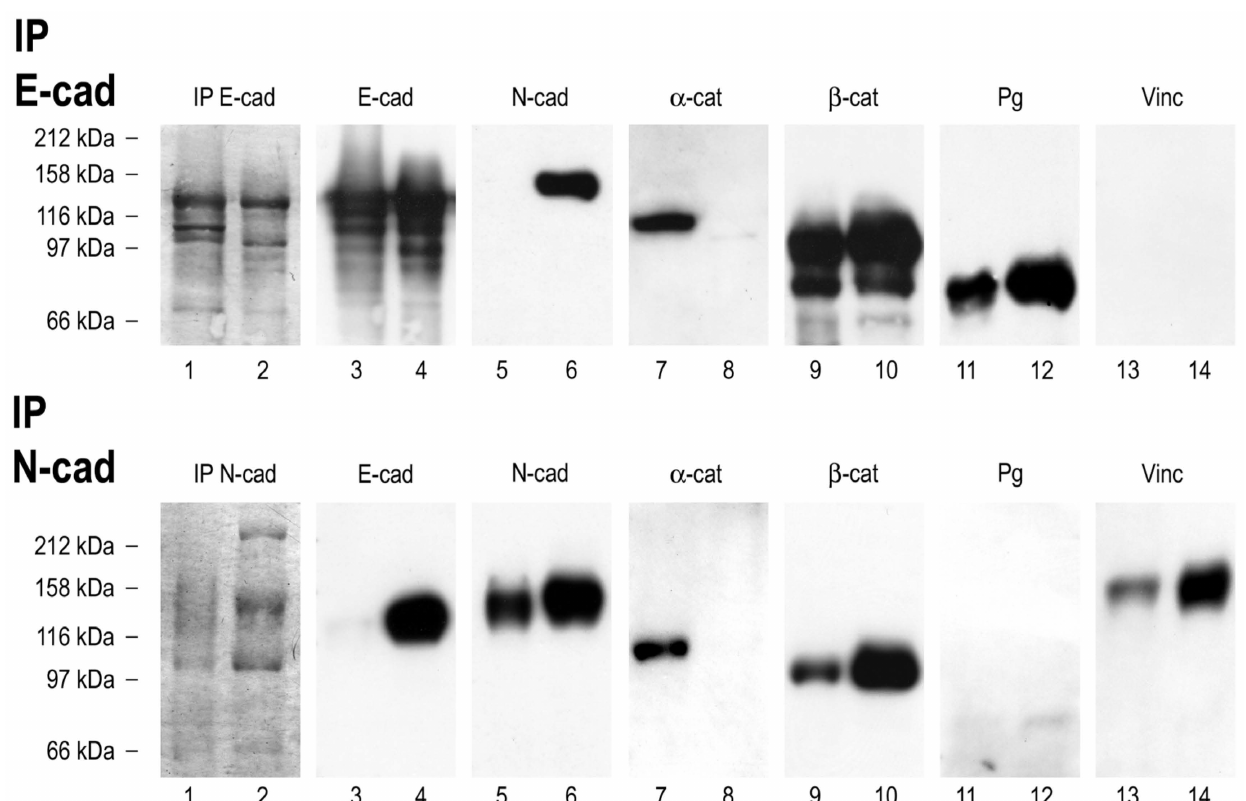
Figure 2. Identification of cis-E:N-cadherin heterodimers in PLC cell lysates, demonstrated by immunoprecipitation, SDS-PAGE (8%), and immunoblotting. Coomassie-Blue-stained major polypep- tides of the immunoprecipitates obtained from 1% Triton X 100 soluble fractions (lane 1), as well as RIPA soluble fractions (lane 2) of PLC cells from protein G-bound antibodies against E-cadherin (above) and N-cadherin (below). Proteins of immunoprecipitates subjected to SDS-PAGE were probed by immunoblotting with antibodies against E-cadherin (lanes 3 and 4), N-cadherin (lanes 5 and 6), α -catenin (lanes 7 and 8), β -catenin (lanes 9 and 10), and plakoglobin (lanes 11 and 12). In each case, on the left hand, immunoprecipitates from Triton X 100 soluble lysates, and on the right hand, immunoprecipitates from RIPA-soluble lysates are shown. Note enhanced coimmunoprecipitation of E- and N-cadherin using RIPA-buffer (IP N-cadherin, lane 4 and IP E-cadherin, lane 6, respectively). On the contrary, α -catenin was coprecipitated with N-cadherin to a greater amount using 1% Triton X 100. Note faint band also detectable using RIPA -soluble lysates. Plakoglobin, however, seems to be physically associated rather with E-cadherin than with the N-cadherin complex. Molecular weight markers are indicated on the